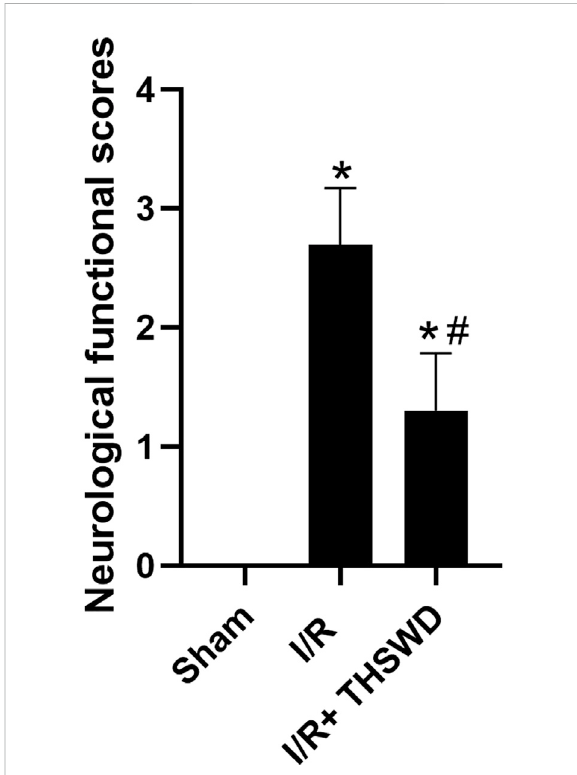
FIGURE 1 Neurofunctional score analysis of taohong siwu decoction (THSWD). Notes: * p < 0.05 vs.Shamgroup; # p < 0.05 vs.I/R